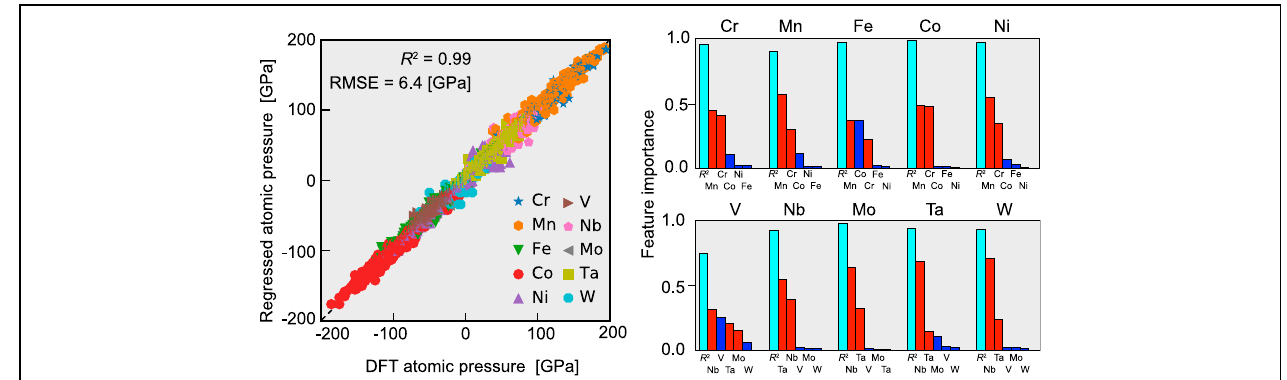
FIGURE 7 | Regression results for the atomic hydrostatic pressure by the random forest method with the features consisting of the numbers of atoms for each element located in the first neighbor shell.